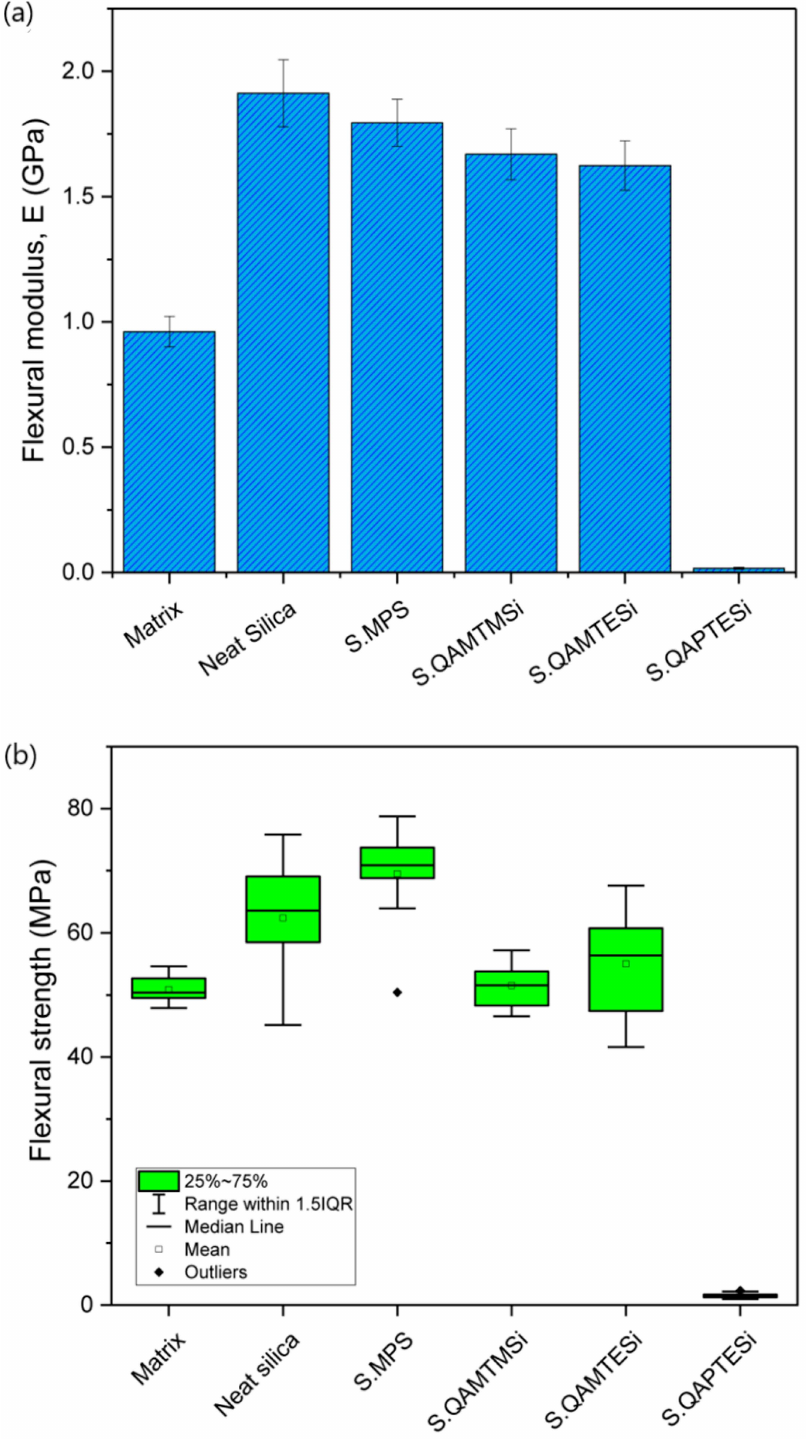
Figure 8. ( a ) Flexural modulus bar plots; ( b ) Flexural resistance box plots for pure Bis-GMA/TEGMA matrix and dental nanocomposite resins filled with different silica